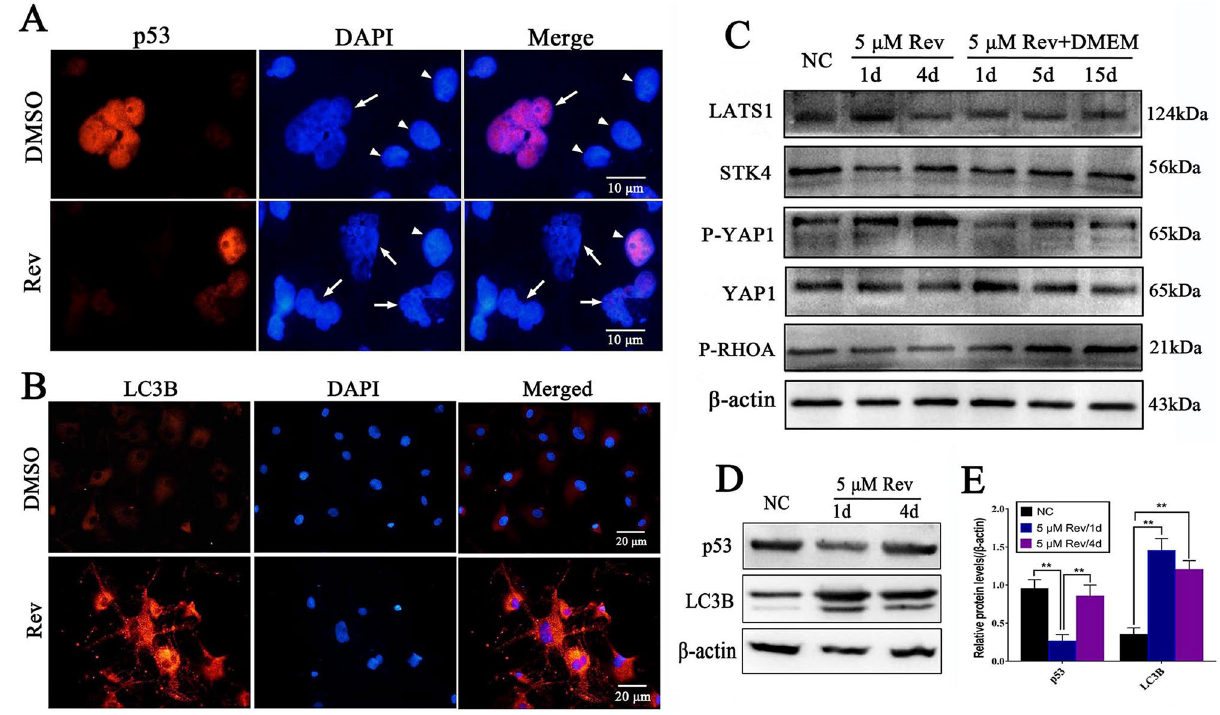
Figure 5. Cytokinesis failure triggers Hippo signaling pathway and P53 inactivation. ( A ) p53 inactivation in reversine treated multinucleated cells, white arrowheads indicate normal fibroblasts, white arrows indicate multinucleated cells. ( B ) Reversine treatment promoted cell autophagy. ( C ) Reversine treatment significantly inhibited RhoA and activated Hippo pathway. ( D ) Western blotting analysis of p53 and LC3B proteins. ( E